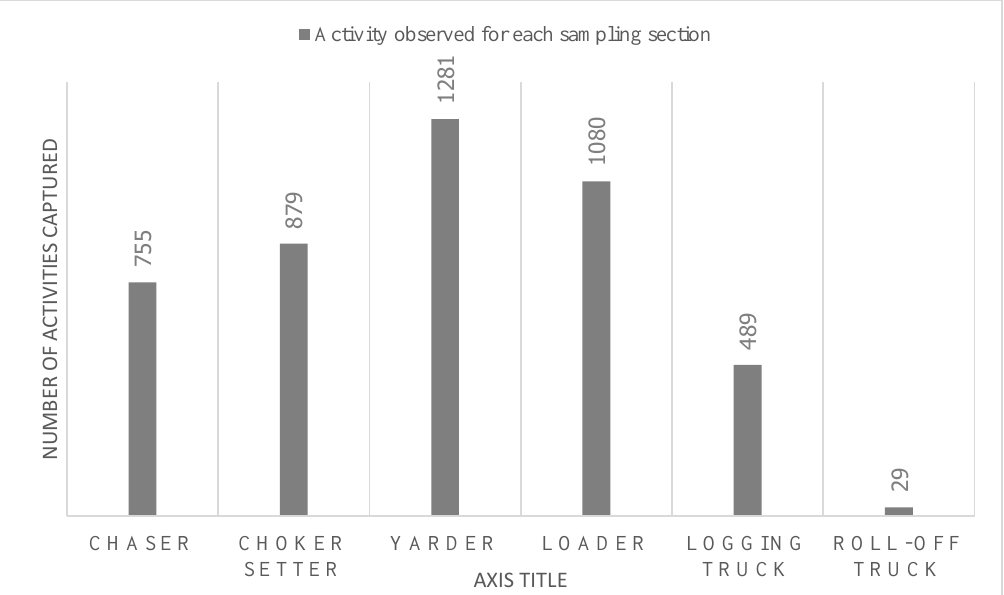
Figure 4. Number of sample sections in which productive activity was observed to evaluate the system balance ( n = 1361). Each sampling section comprised of 15 seconds and was collected from sampling windows with 120 sampling sections (30 minutes).